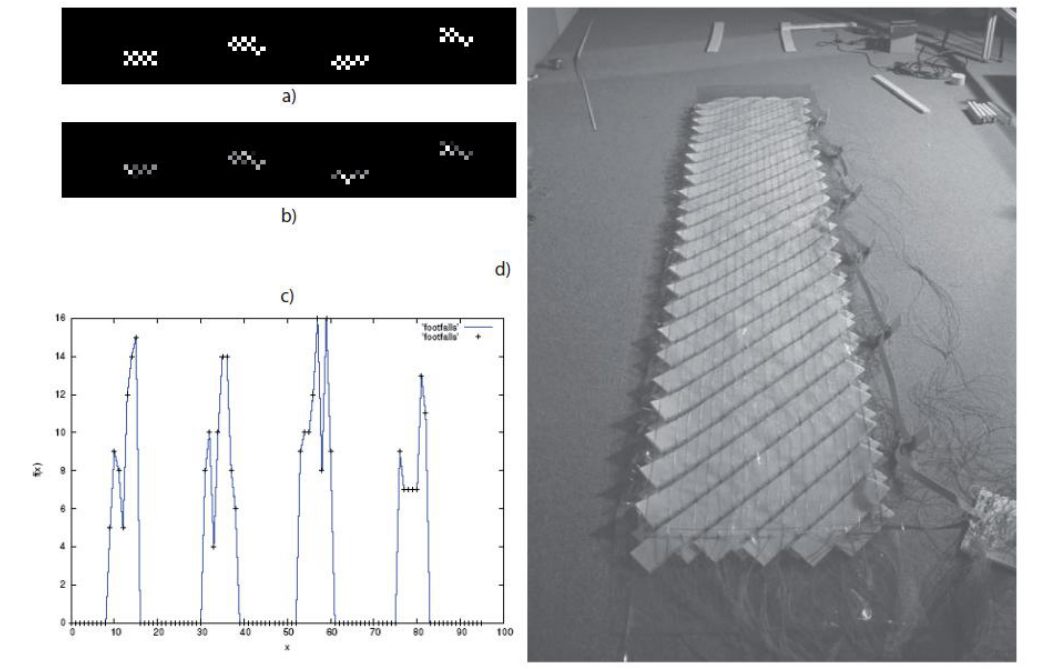
Figure 4. Gait analysis using floor sensors. ( a ) Steps recognized; ( b ) time elapsed in each position; ( c ) profiles for heel and toe impact; and finally ( d ) image of the prototype sensor mat on the floor. Reproduced with permission from University of